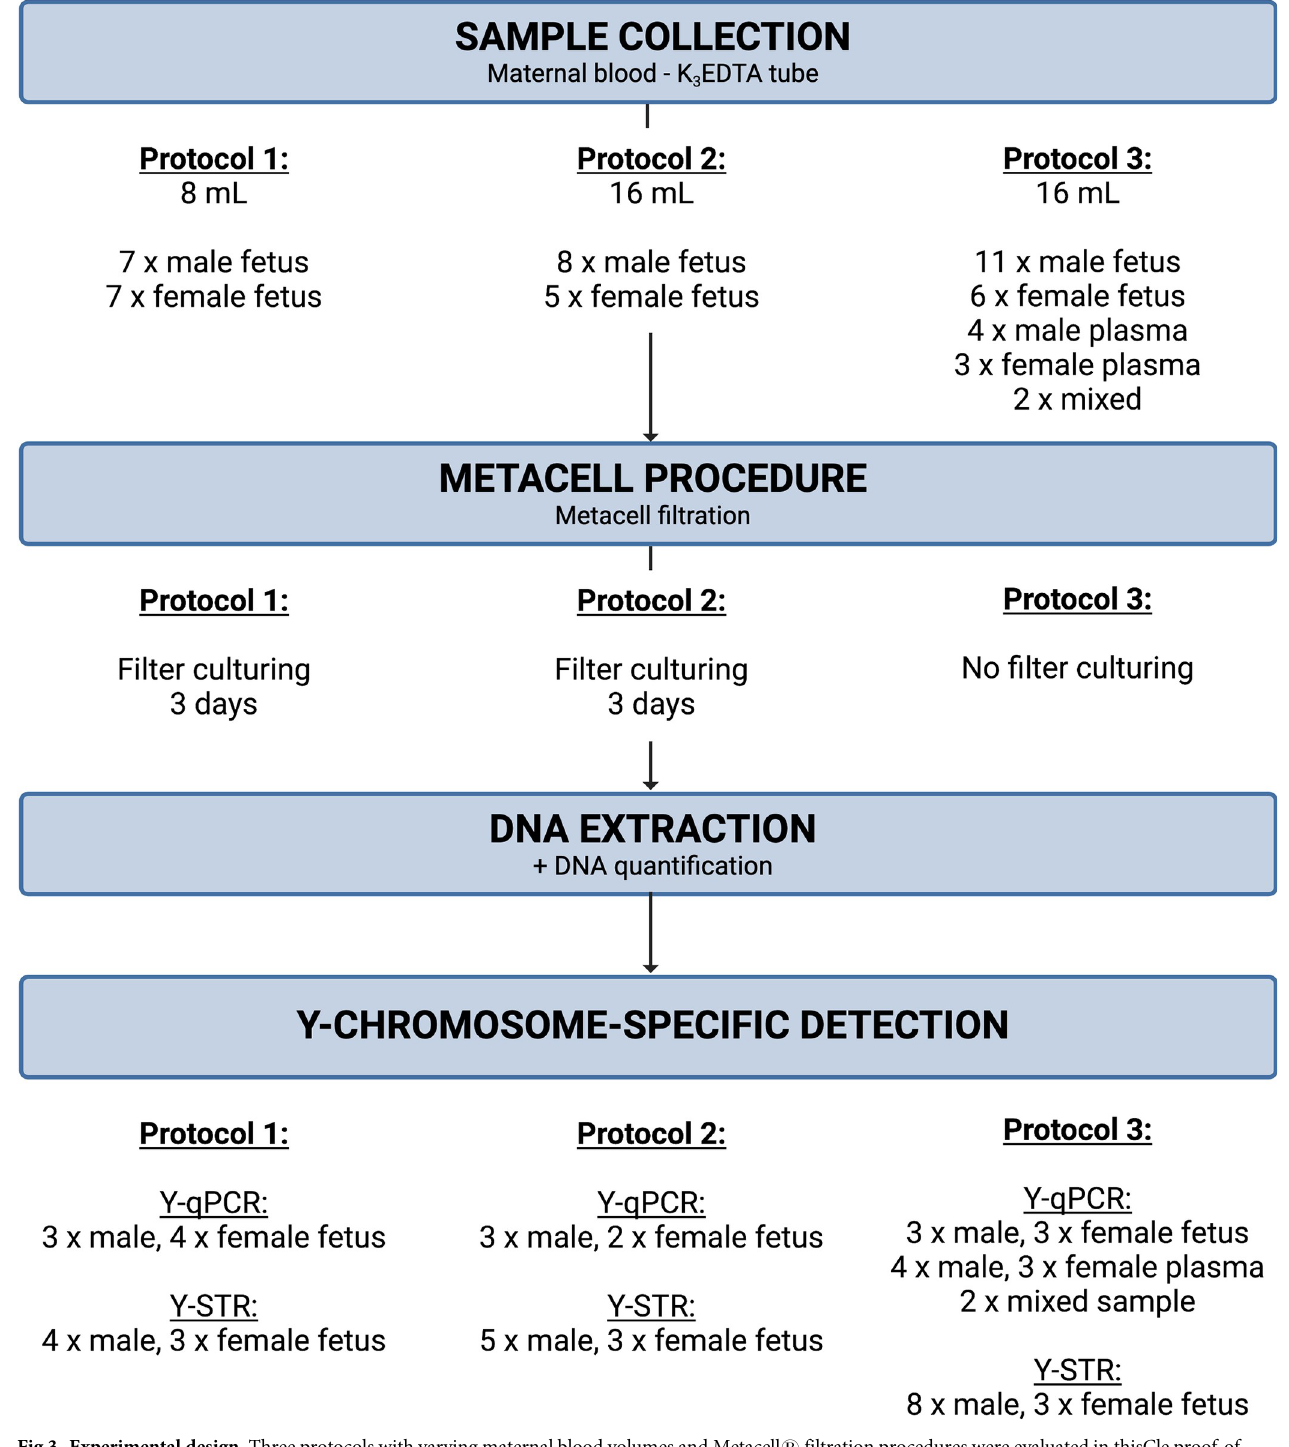
Fig 3. Experimental design. Three protocols with varying maternal blood volumes and Metacell 1 filtration procedures were evaluated in thisCle proof-of- concept study. Each protocol comprises sample collection, Metacell 1 procedure, DNA extraction, and Y-chromosome-specific detection.